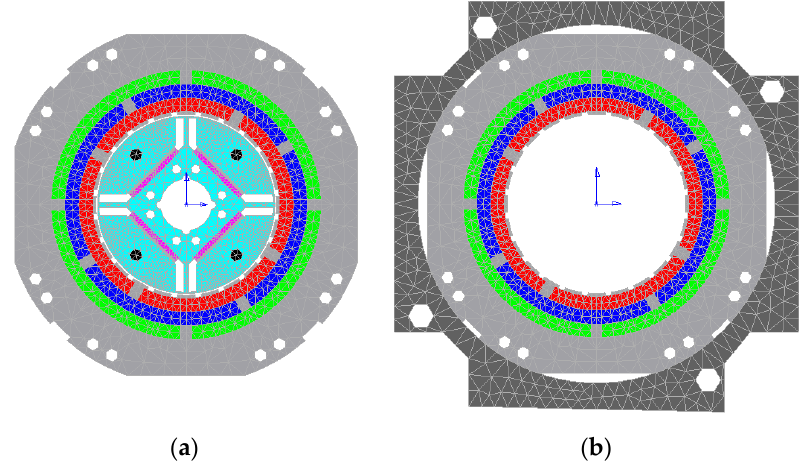
Figure 10. Experimental IPMSM.